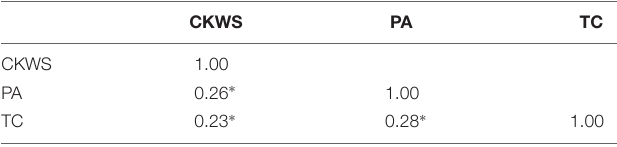
TABLE 3 | Correlations between the three principal components, conceptual knowledge of the writing system (CKWS), phonological awareness (PA), and textual competence (TC).